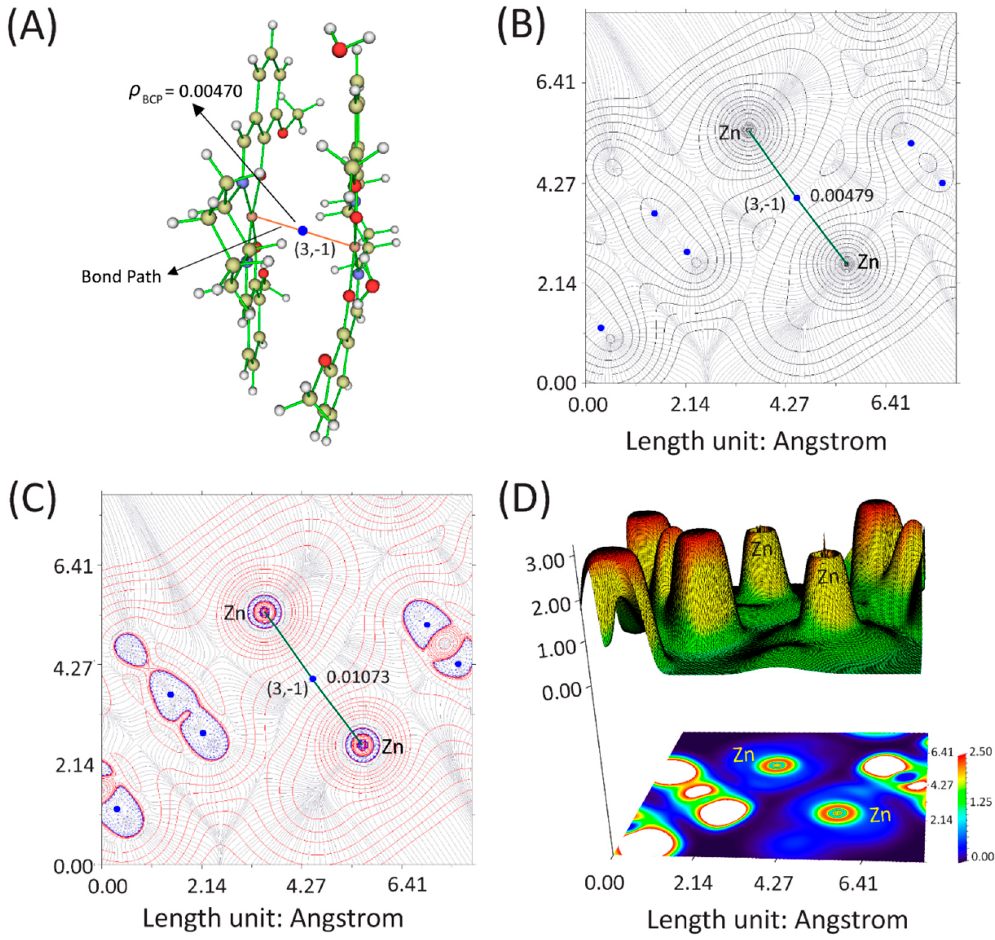
Figure 7. QTAIM analysis [Zn(sal)](H 2 O) (dimeric form): ( A ) molecular graph, showing the bond path and electron density ( ρ ) at BCP. ( B ) Contour line plots of the electron density ρ , ( C ) contour line plots of the Laplacian of electron density ∇ 2 ρ (r), the solid (red) and dashed (blue) lines corresponds to positive and negative values of ∇ 2 ρ (r) respectively, ( D ) surface maps of electron localization function (ELF). Bond paths are shown as green lines, selected zero-flux surfaces or interbasin paths as blue lines, bond critical points, BCPs (3, − 1) are shown in blue.